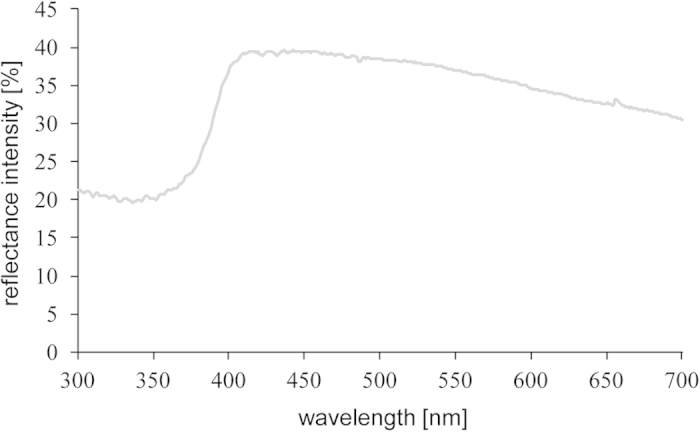
Reflectance spectrum of the visual background.Mean reflectance (proportion of light reflected in relation to a white standard (see text)) of the visual background used during rearing and in the experimental set-up.